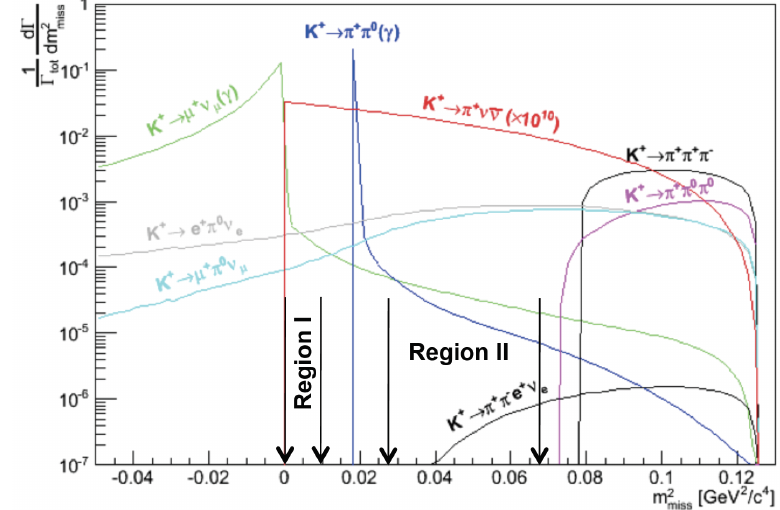
Figure 2. Squared missing mass distribution of K + decays relevant to the K + → π + ν ¯ ν measurement. The m 2 variable is computed under the hypothesis that the charged particle in the final state is a miss positive pion. The signal (red line) is multiplied by 10 10 for visibility. Two regions where to search for the signal are also